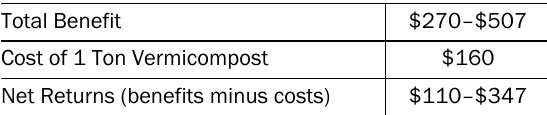
Table 5. Additional Net Returns for the Farm